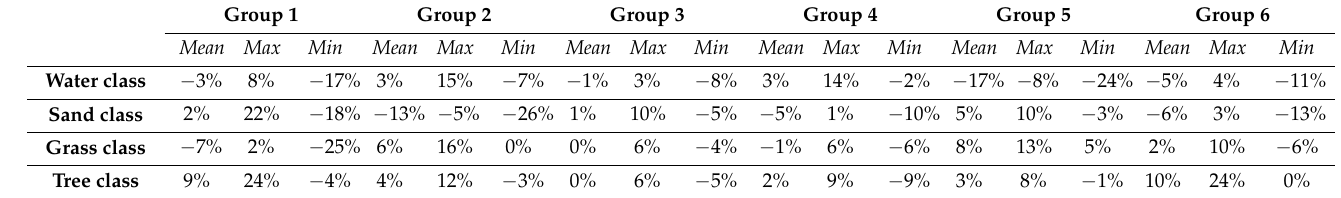
Figure 11. Average differences in land cover areas across Groups 1–6 classified according to Ward’s method. Table 3. Land cover differences characteristic in Groups 1–6 classified according to Ward’s